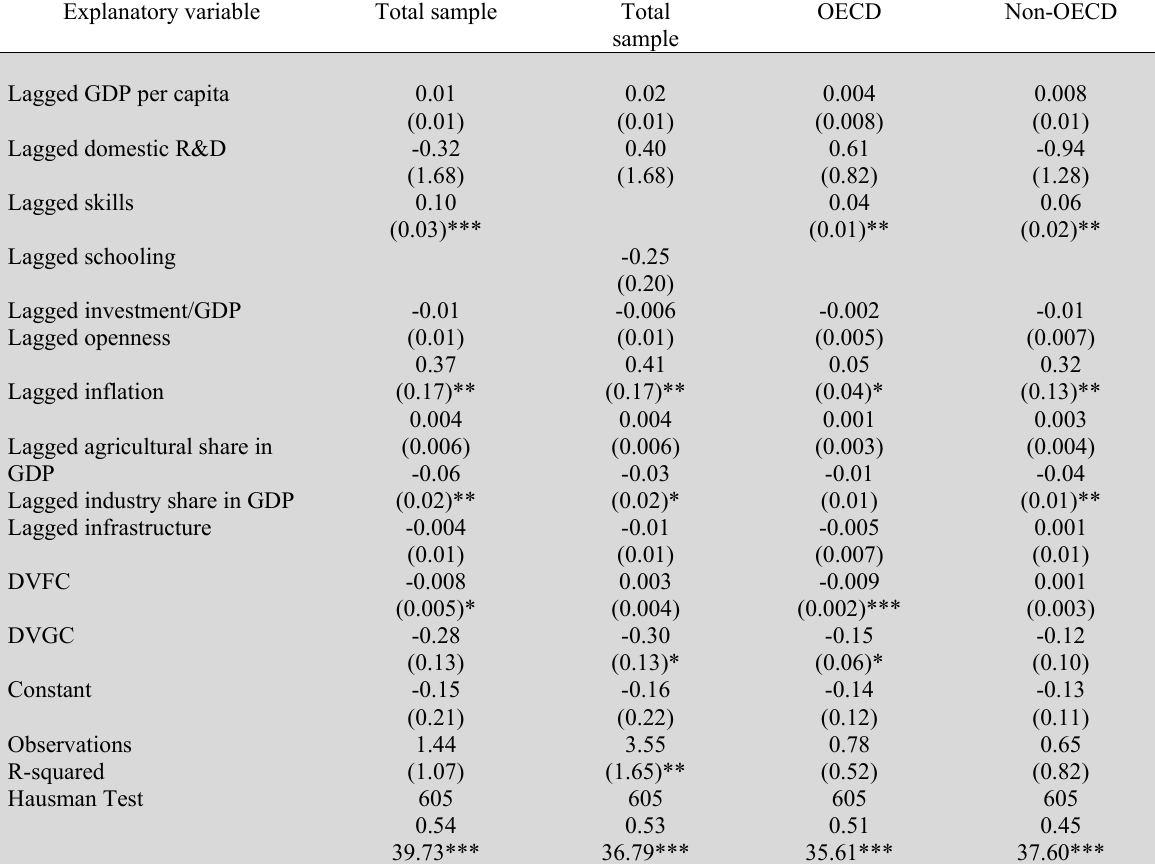
The determinants of technology transfer in Vietnam (one year lag) (Fixed effects panel data estimate) Dependent variable: The ratio of capital goods imports to